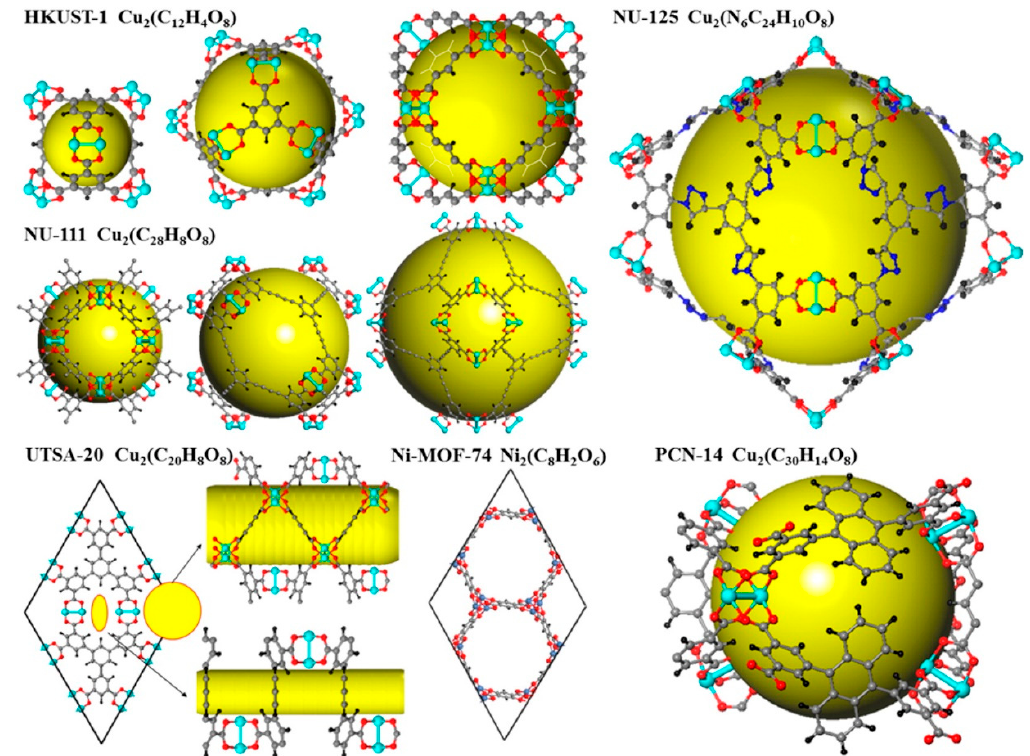
Figure 1. Nanocages of NU-111 (NU = Northwestern University), Ni-MOF-74 (MOF = metal-organic framework), PCN-14, UTSA-20 (UTSA = University of Texas at San Antonio), HKUST-1 (Hong Kong University of Science and Technology), and NU-125 and their empirical formulas. Carbon atoms are shown as gray spheres, hydrogen atoms are shown as black spheres, oxygen atoms are shown as red spheres, copper atoms are shown as cyan spheres, and nitrogen atoms are shown as blue spheres. Adapted with permission from Reference [9]. Copyright 2013 American Chemical Society.